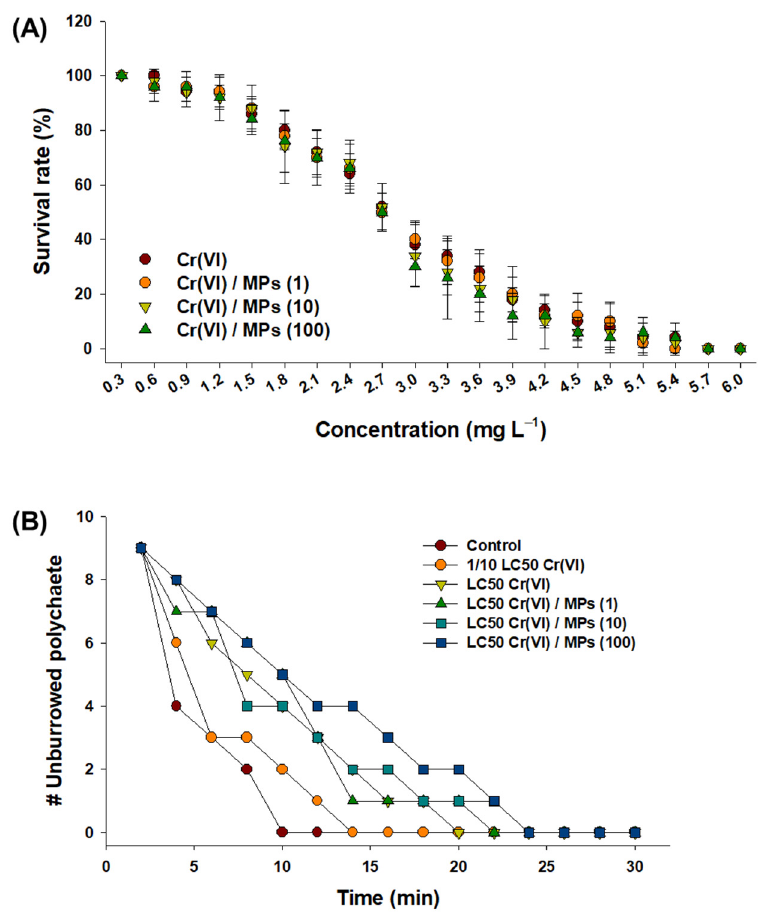
Figure 4. Results of acute toxicity and the burrowing behavior of the polychaete P. aibuhitensis. ( A ) Measurement of the 96-h survival rate of P. aibuhitensis in response to different concentrations of Cr(VI) (0.3–6.0 mg L − 1 ) and the combination of Cr(VI) and 1 μ m MPs (1, 10, and 100 particles L − 1 ). Data are presented as mean ± standard deviation (S.D.) of five replicates (n = 10 per replicate). ( B ) Effects of the LC50 concentration of Cr(VI), its 1/10 LC50 value, and the combination of Cr(VI) and 1 μ m MPs (1, 10, and 100 particles L − 1 ) on the burrowing behavior of P. aibuhitensis . Data are presented as mean ± standard deviation (S.D.) of 20 individuals.